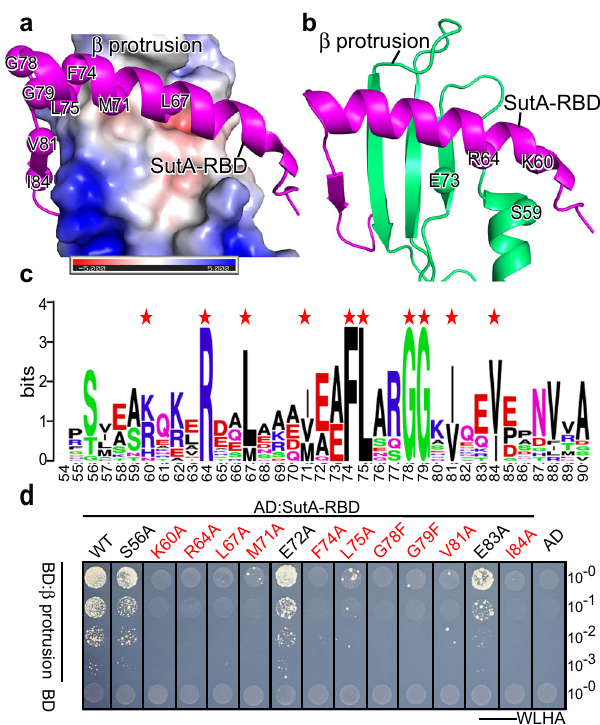
Fig. 4 The detailed interactions between SutA-RBD and RNAP- β protrusion. a The hydrophobic residues of SutA-RBD interact with a non- polar surface of RNAP- β protrusion. b The possible polar contacts made by nearby polar residues of SutA-RBD and RNAP- β protrusion. c Protein sequence alignment of SutA from 17 non-redundant bacterial species. Red asterisks indicate interface residues. d Alanine substitution of the interface residues disrupts interactions between SutA-RBD and RNAP- β protrusion. Source data are provided as a Source Data fi